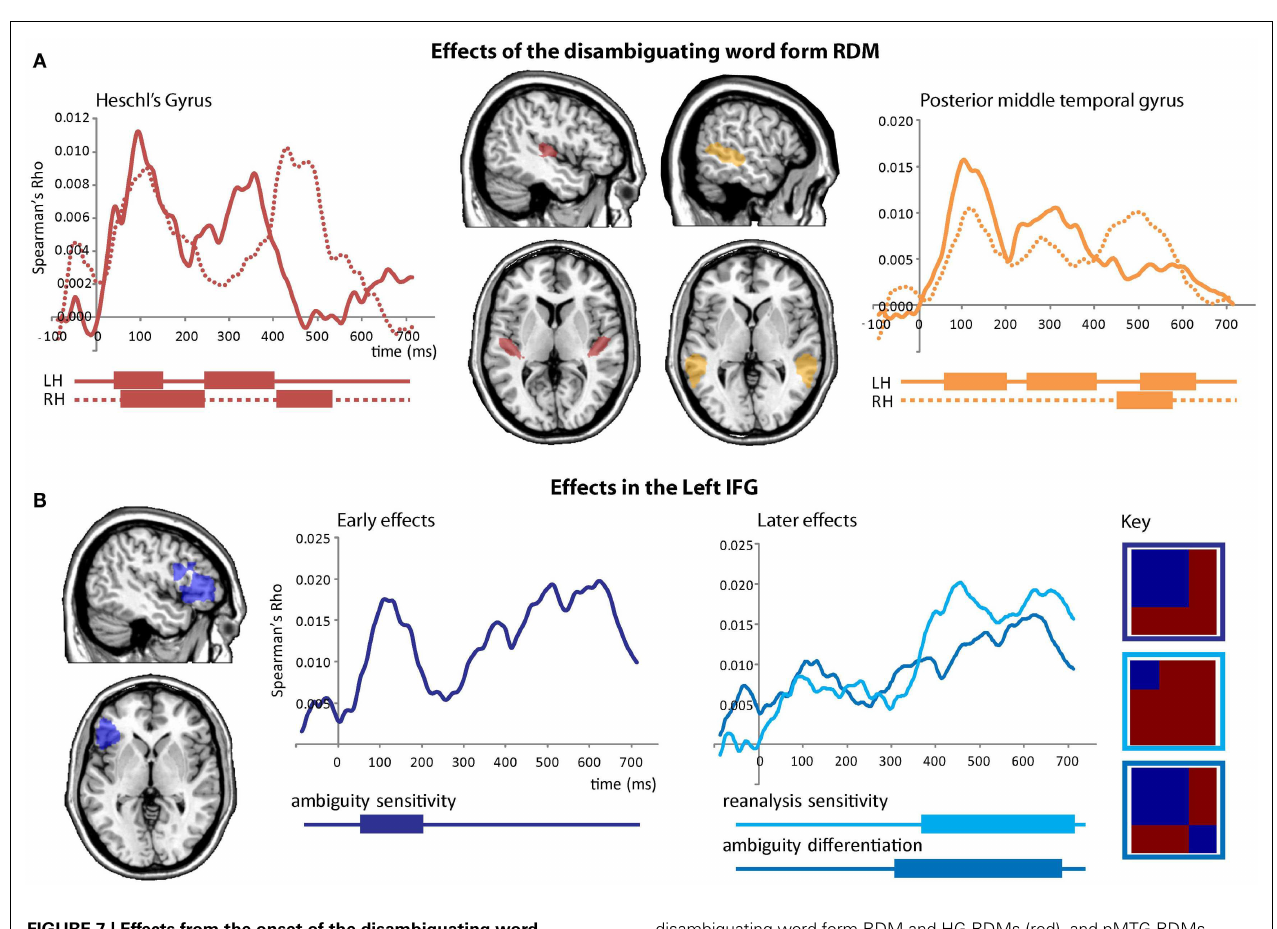
FIGURE 7 | Effects from the onset of the disambiguating word . (A) Effects of the disambiguating word form RDM captures similarity according to the acoustic input which is found in bilateral HG and pMTG. Plots show time-course of similarity between the